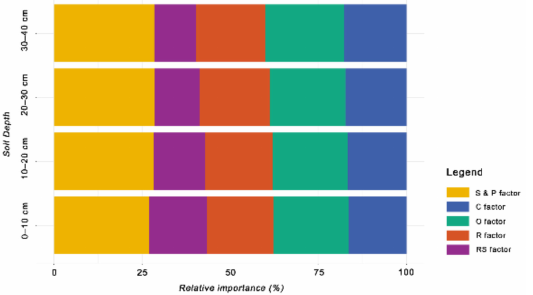
Figure 6. Relative importance of environmental covariates when fitting RF models, where S and P factor is the soil and parent material factor, C factor is the climate factor, O factor is the organism factor, R is the relief factor and RS is the remote sensing factor.